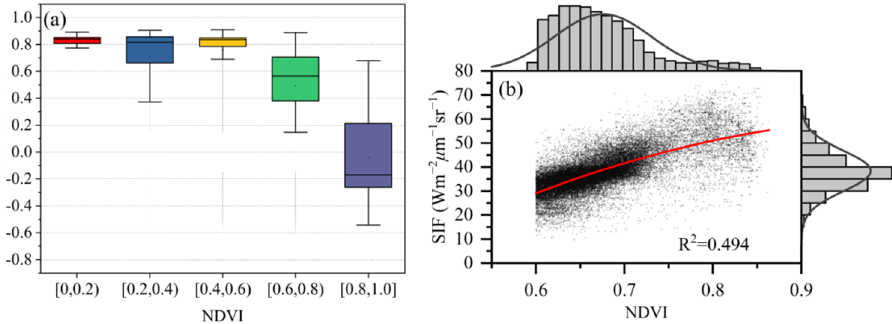
Figure 8. ( a ) The correlation coefficients obtained between the SIF and the NDVI at different NDVI intervals for the whole of China; ( b ) the relationships between the NDVI and the SIF obtained in high-coverage-level forest vegetation